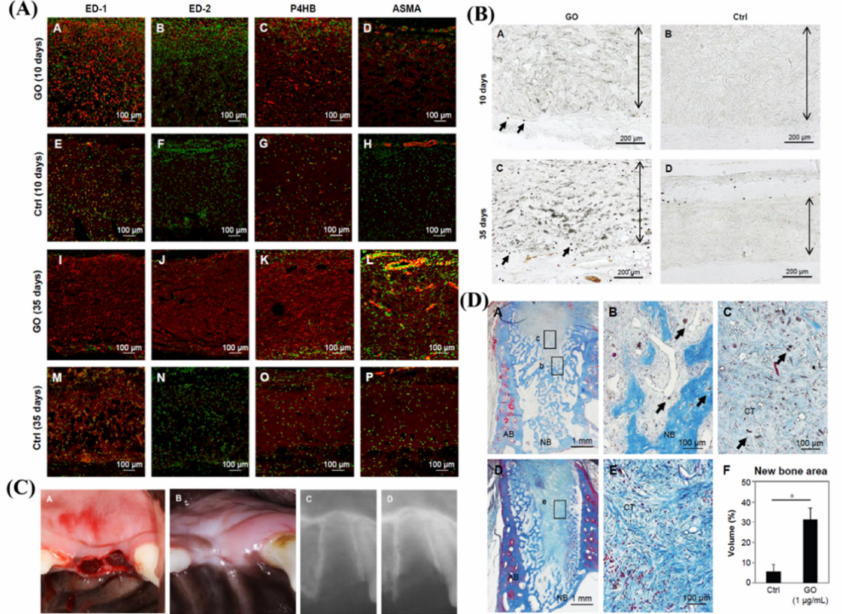
Figure 3. Graphene oxide (GO) coating on a collagen scaffold enhances alveolar bone regenera- tion. ( A ) Immunohistochemical assessment of subcutaneous tissue with scaffold implantation. ED1 and ED2 indicate macrophages, P4HB indicates fibroblasts, and ASMA indicates blood vessels, in red. I ( B ) Peroxidase staining of subcutaneous tissue implanted with scaffold. Arrows and double arrows indicate peroxidase-positive granulocytes and the implanted scaffold, respectively. ( C ) Pho- tographs and radiographic images immediately and 2 weeks after the implantation of the GO scaffold ( D ) Histological assessments of new bone formation in the extraction socket at 2 weeks after scaffold implantation; arrows indicate residual GO. *, p < 0.05. [123] Copyright 2016, the